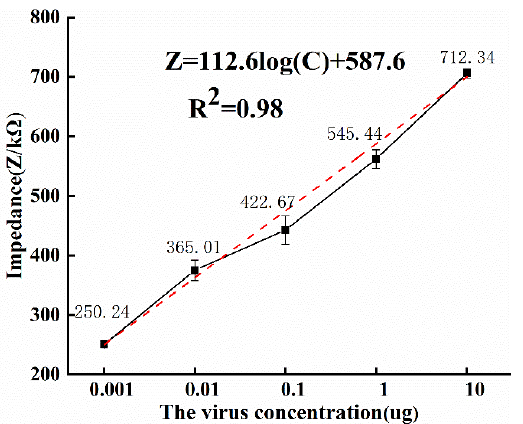
Figure 7. Diagram of concentration – impedance at the optimal detection frequency.